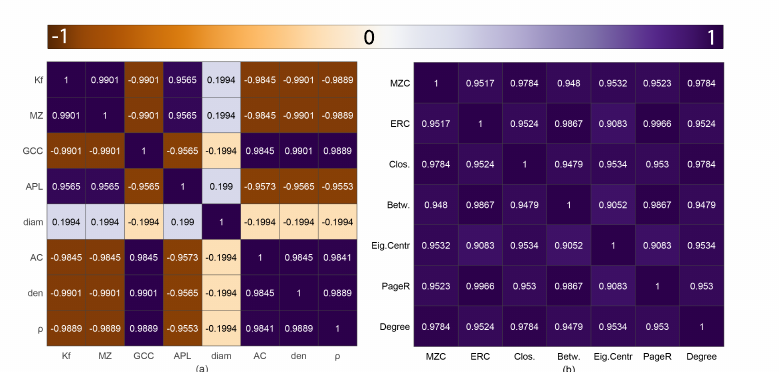
Figure 7. ( a ) The correlation between the global graph measures for more than 10 3 graphs generated by the Erdös − Rényi model with 2500 vertices and p ∈ [ 0.5,0.001 ] . ( b ) The correlation between the local measures of each vertex of the graph generated by the Erdös − Rényi model with 2500 vertices and p = 0.08.